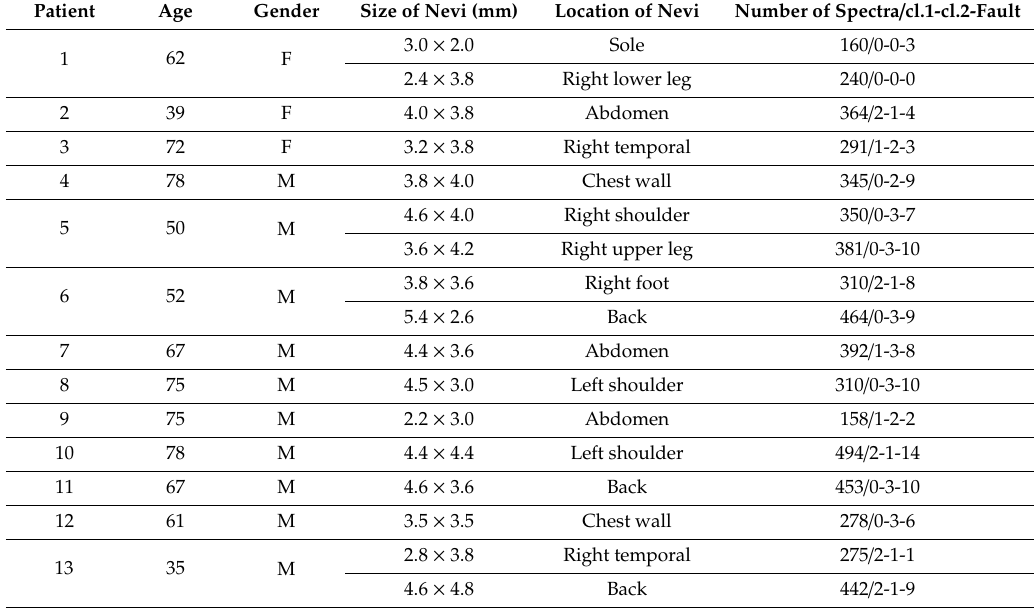
Table 1. Overview of the data of the patient cohort and the nevi; F = female, M = male, cl.1 = class 1, cl.2 = class